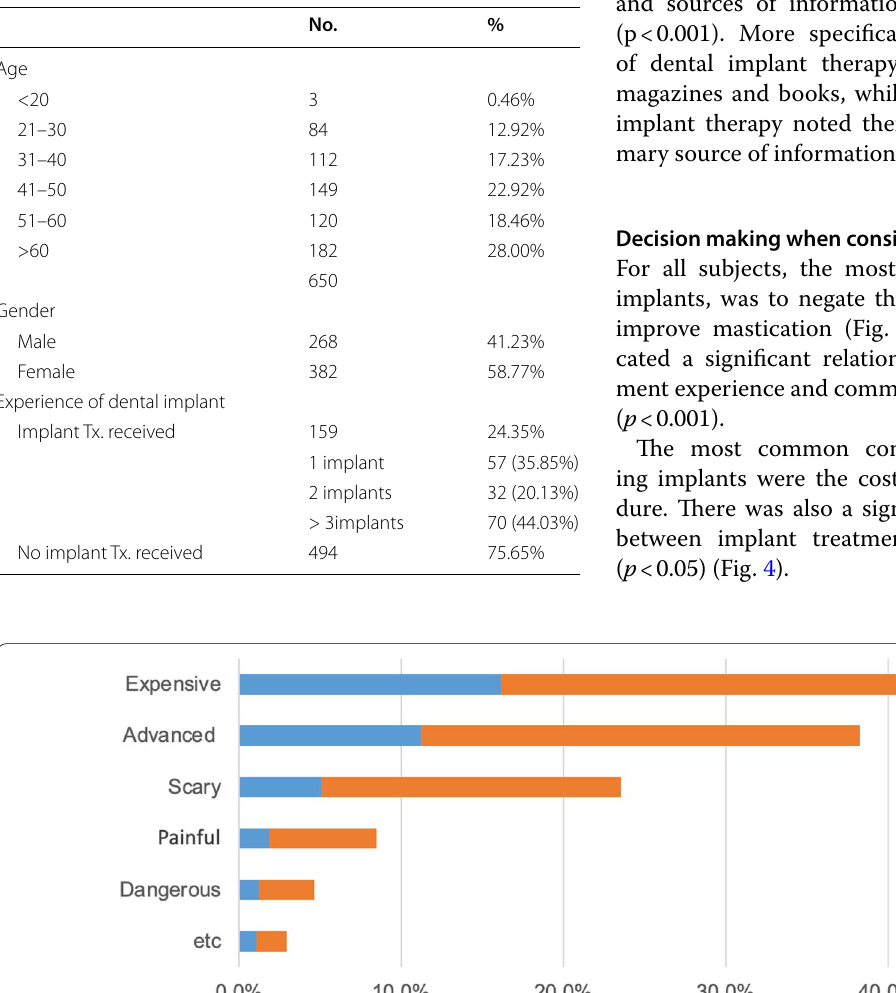
Table 1 Demographic structure of the